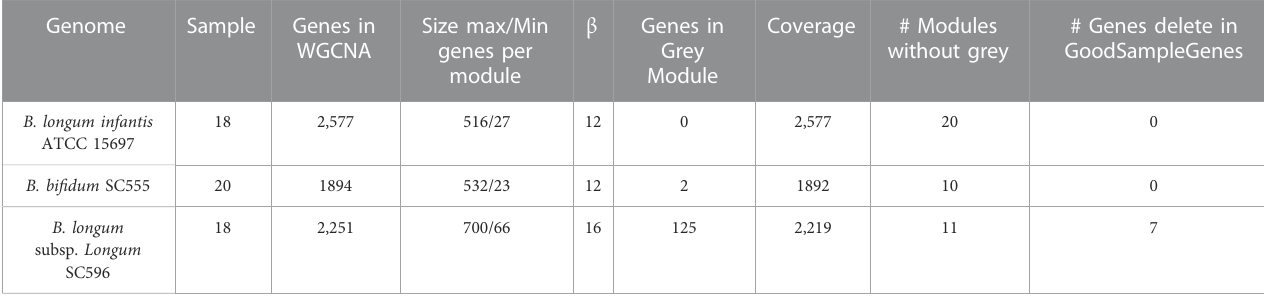
TABLE 1 Overview of dataset and co-expression modules in this